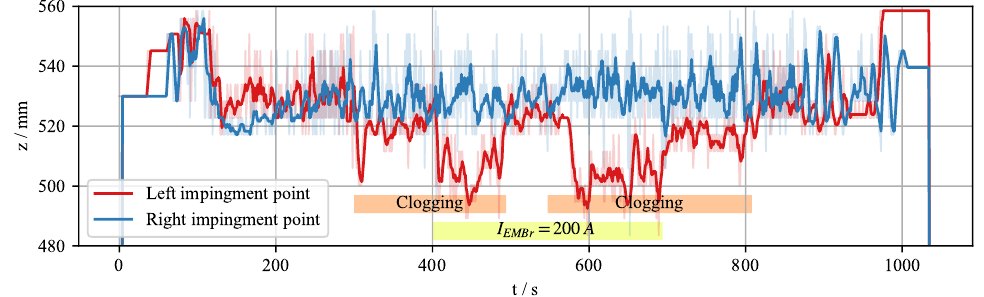
Figure 6. Jet impingement position at both sides of the mould. Less opaque background graph shows the raw position of the impingement point. Solid lines show the running average of the respective impingement point. Running mean window is ten samples (5